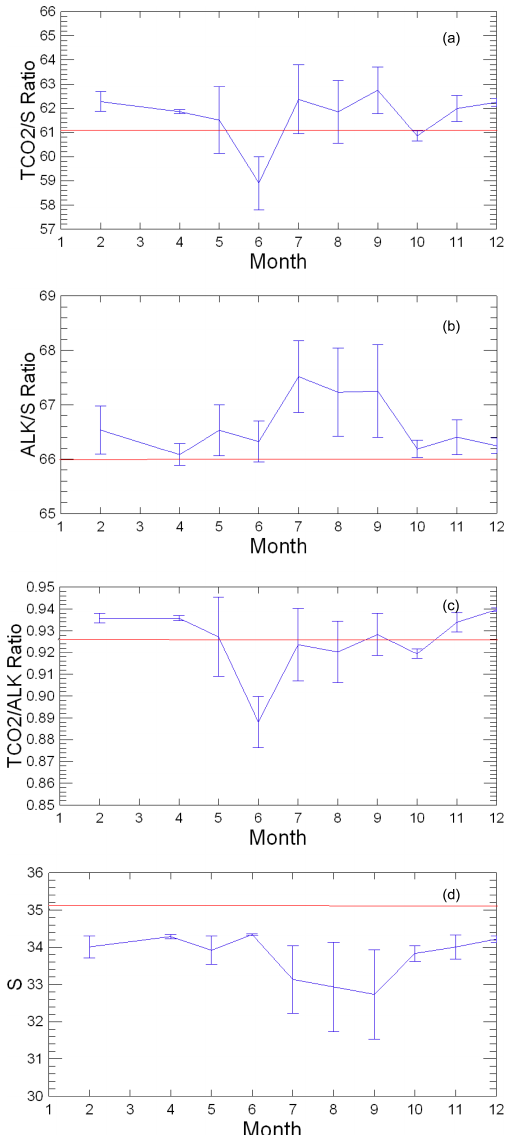
Figure 6. Polar Water seasonal carbonate chemistry variations. Composite Polar Water data from the 25m surface layer. The sea- sonal variations in the (a) total inorganic carbon / salinity ratio, µmolkg − 1 psu − 1 ; (b) alkalinity / salinity ratio, µmolkg − 1 psu − 1 ; and (c) total inorganic carbon / alkalinity ratio reflect biological car- bon assimilation and inorganic processes associated with freshwater inputs which lower the salinity (d) to the annual minimum in late summer. The error bars indicate ± 1 standard deviation from the monthly means. The red horizontal lines mark the Atlantic Water benchmarks (Table